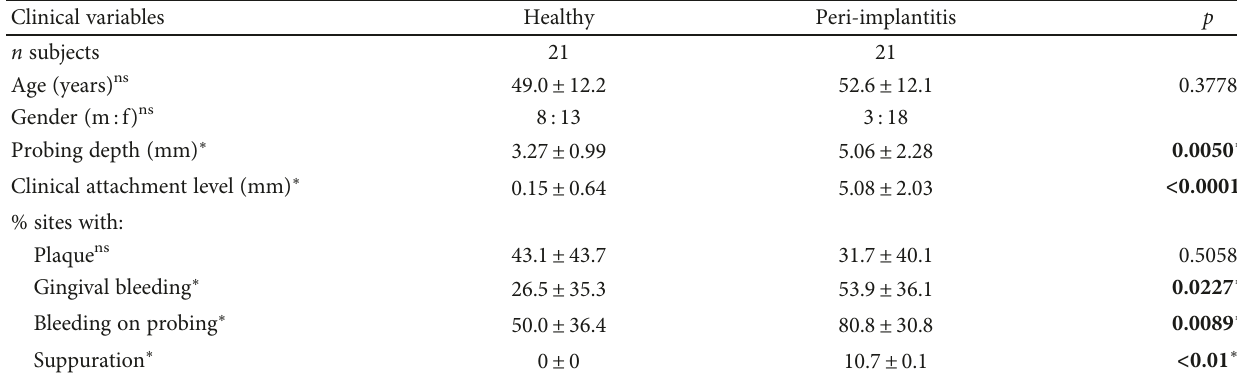
Table 1: Mean ± SD of clinical characteristics of the subjects in both groups.